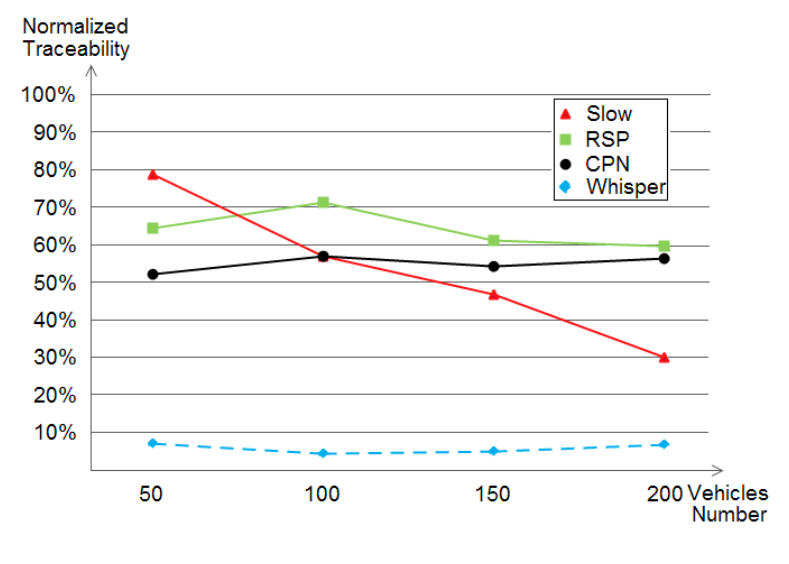
Figure 12. The achieved normalized traceability by SLOW, RSP, CPN, and WHISPER within differ- ent densities.